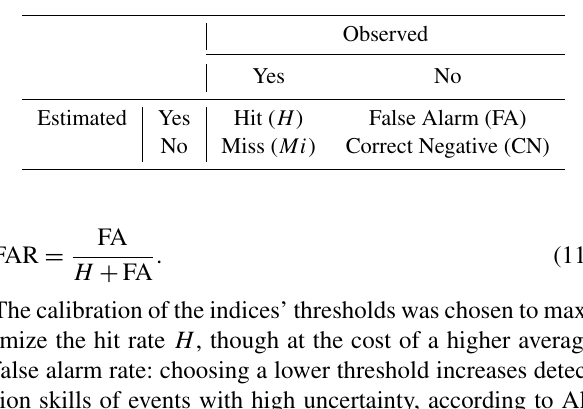
Table 3. Contingency table structure used for the validation analy-